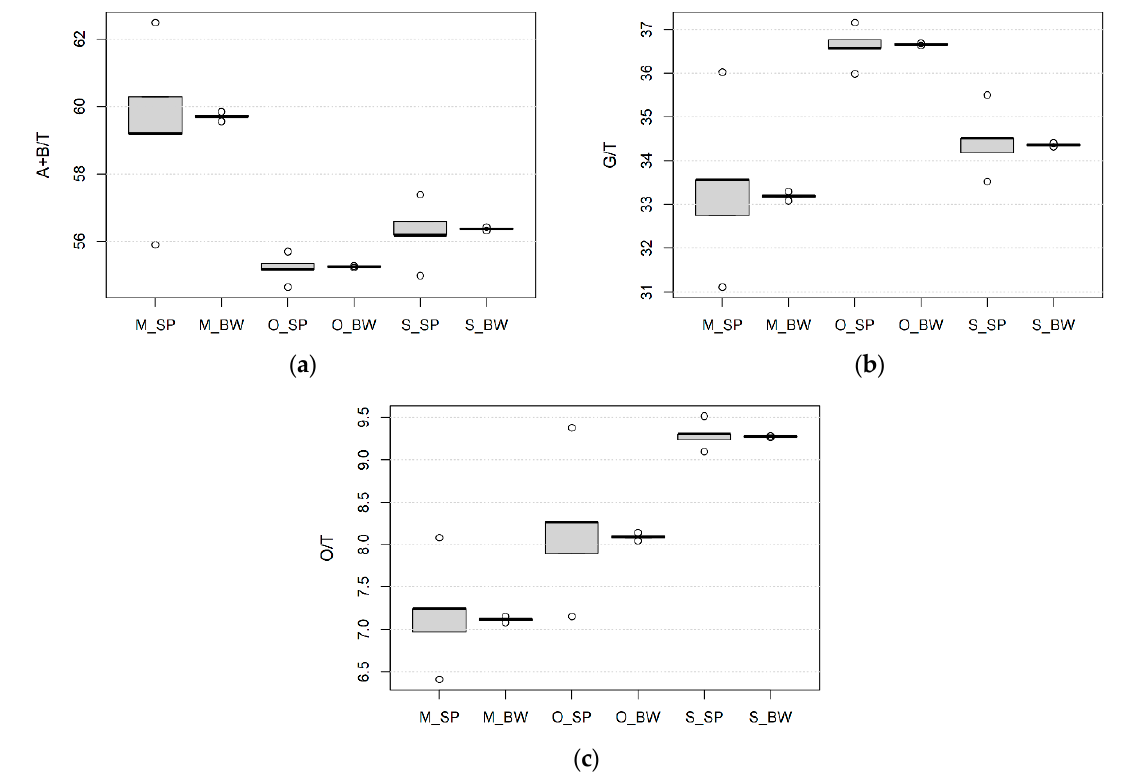
Figure 3. Boxplots for ( a ), A+B/T—the quantitative ratio of alfa and beta gliadins in total gliadins, ( b ) G/T—the quantitative ratio of gamma gliadins in total gliadins, ( c ) O/T—the quantitative ratio of omega gliadins in total gliadins; SP—spelt wheat, BW—bread wheat, M—conventional growing site in Martonvásár, Hungary, O—organic growing site in Hungary, S—conventional growing site in Serbia; minimum value excluding outliers—shown by the line at the end of the bottom whisker; the first lower quartile (25th percentile)—shown by the lower end of the box; median—shown by the horizontal line inside the box; the third upper quartile (75th percentile)—shown by the upper end of the box; maximum value excluding outliers—shown by the line at the end of the upper whisker; outliers—shown by the empty circles.